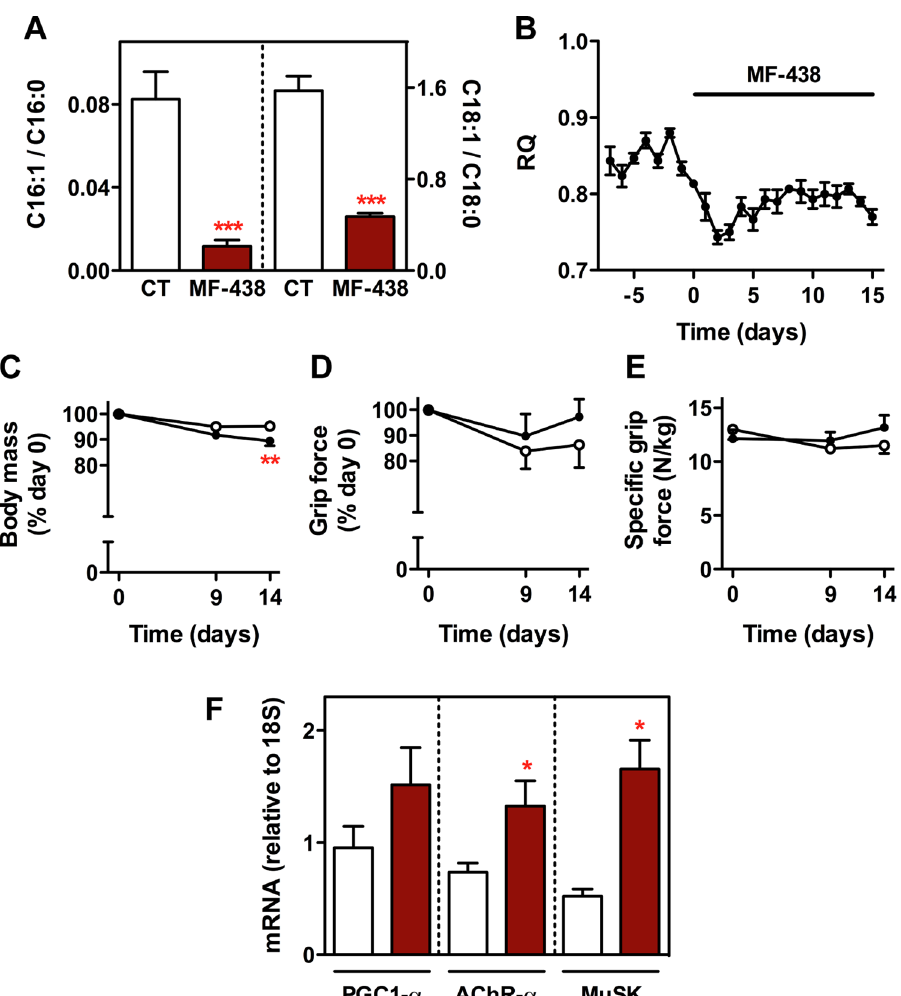
Figure 5. Effects of MF-438 on metabolism and muscle function. (A) C16:1/C16:0 and C18:1/C18:0 fatty acid ratio in plasma from MF-438 treated mice (brown columns) and control littermates (CT, white columns). *** P , 0.001 (Unpaired t-test, n=4–6). (B) Time course of respiratory quotient (RQ) before and after treatment with MF-438 at a dose of 10 mg/kg body mass/day (indicated by the black bar) (n=4). Time course of body mass (C), muscle grip strength expressed as a percentage of day 0 (D), and specific grip strength, as determined by normalizing peak force to body mass (E), in mice fed regular chow (white circles) and mice fed regular chow supplemented with MF-438 (black circles). ** P , 0.01 (2-way ANOVA followed by Bonferroni test, n=5–6). (F) Expression of PGC1- a , AChR- a , and MuSK in gastrocnemius from MF-438 treated mice (brown columns) and control littermates (white columns). * P , 0.05 (Unpaired t-test, n=3–9).